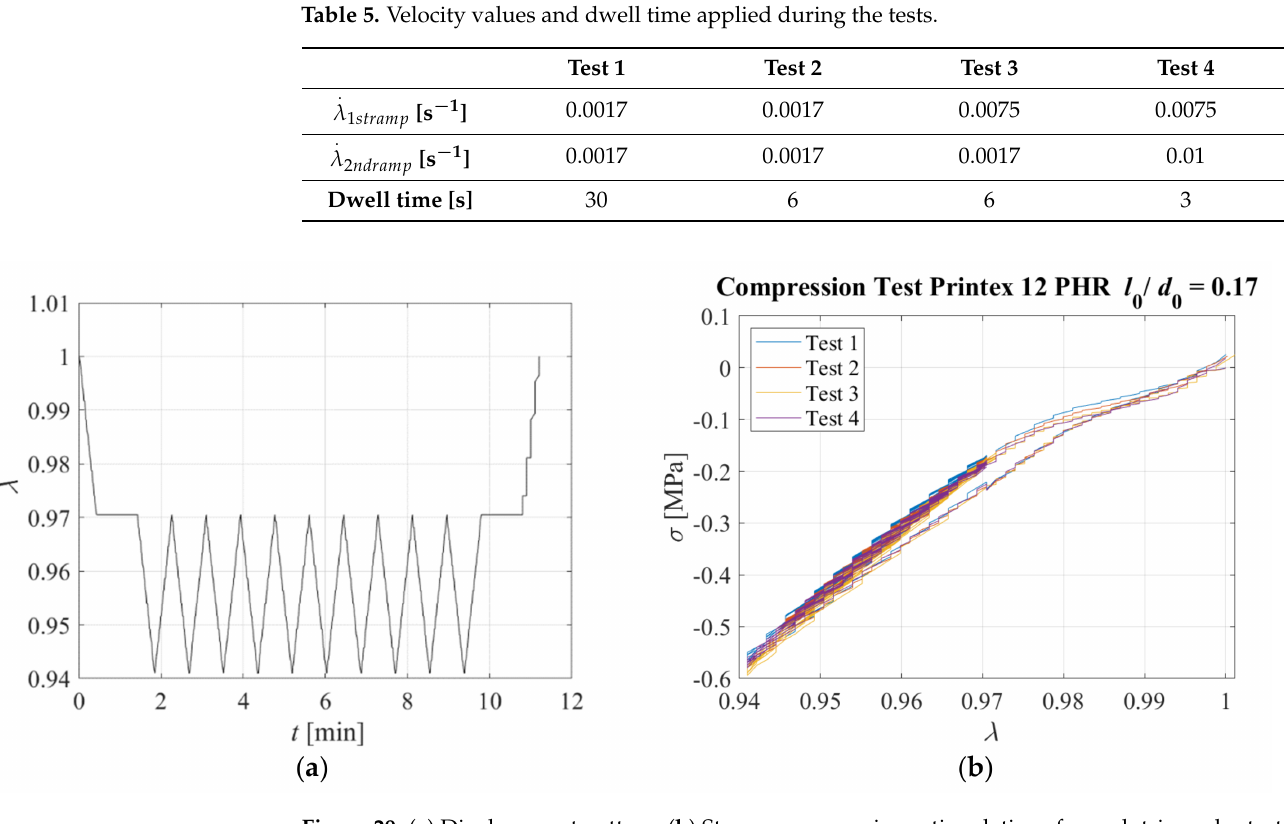
Figure 29. ( a ) Displacement pattern, ( b ) Stress − compression ratio relations for each triangular test. Specimen with l 0 / d 0 =